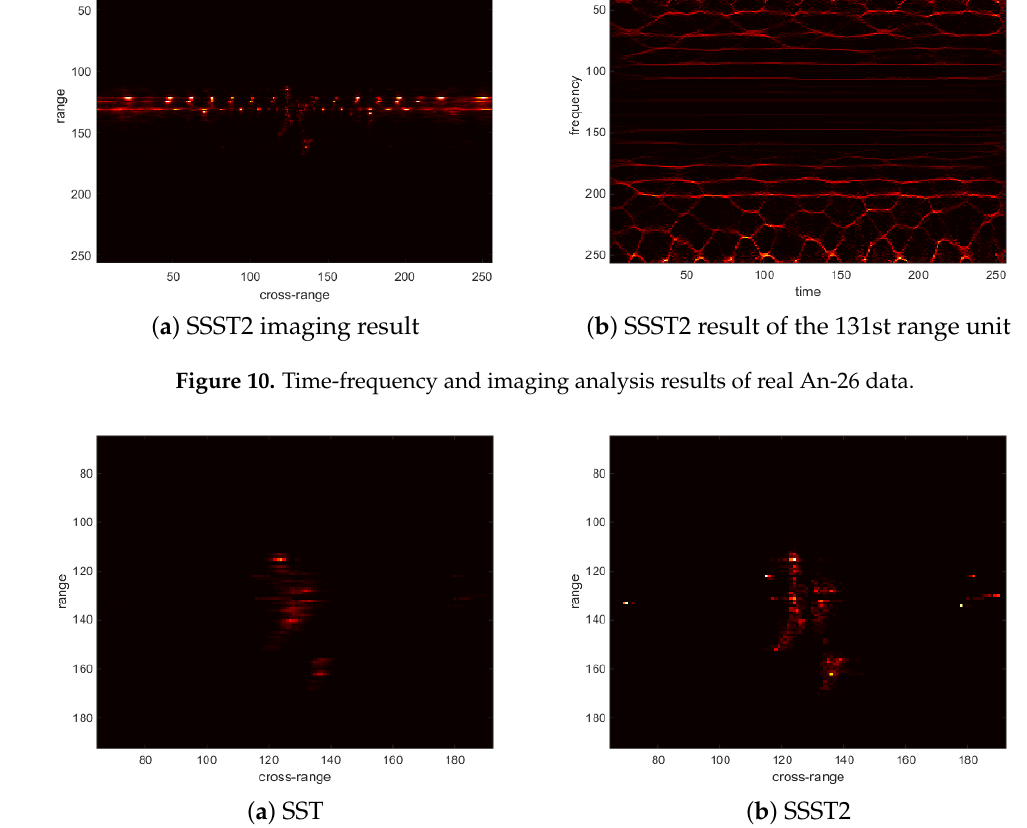
Figure 11. Imaging separation results of real An-26